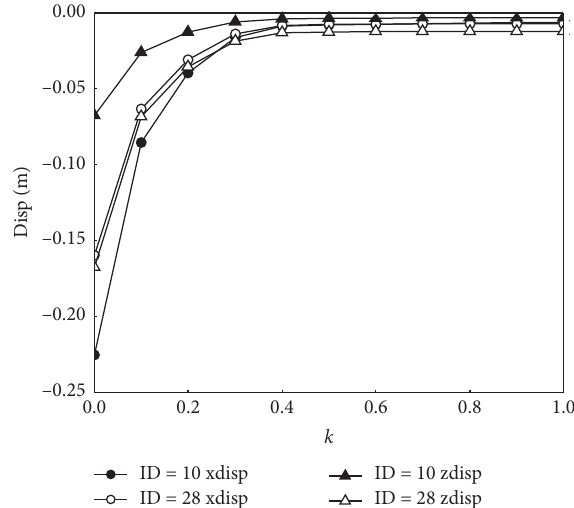
Figure 12: The displacement of the special point with k